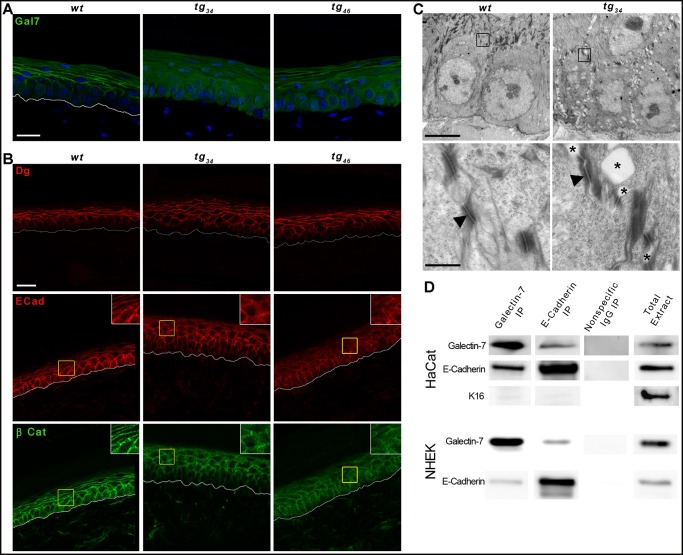
Aberrant intercellular junctions in tg
34 and tg
46 epidermis.(A-B) Confocal analysis of immunofluorescent stainings performed on paraffin sections of wt, tg
34 and tg
46 tail skin. Three to five mice were used for each genotype. White lines delineate the dermo-epidermal junction. Scale bar: 20μm. (A) Galectin-7 profile. Enhanced galectin-7 staining is detectable in both basal and suprabasal cells of tg
34 and tg
46 epidermis compared to wt. (B) Intercellular junctions. Desmosomes are labeled by anti-desmoglein (Dg) staining which appears similar in wt, tg
34 and tg
46 epidermis. Adherens junctions are marked by anti-E-cadherin (Ecad) and anti-ß-catenin (ß-cat) staining. A more diffuse signal was observed in tg
34 and tg
46 samples compared to the wt control. (C) Transmission electron microscopy analysis. Upon low magnification, large regions exhibiting aberrant widening of intracellular spaces are observed in transgenic epidermis (upper panels). Higher magnification analysis revealed the presence of large intercellular spaces in transgenic tissue (asterisks) compared to wt (lower panels). There is a loss of adherens junctions while desmosomes (black arrowheads) are preserved in transgenic epidermis. Two mice were used for each genotype. Scale bars: upper panels: 5μm; lower panels: 0.5μm. (D) Coimmunoprecipitation experiment on cell lysates of HaCat (top panels) or primary normal human epidermal keratinocytes (NHEK, passage 2; bottom panels), using anti-galectin-7 and anti-E-cadherin antibodies. Whole cell extracts and normal IgG immunoprecipitations were used as positive and negative controls, respectively.